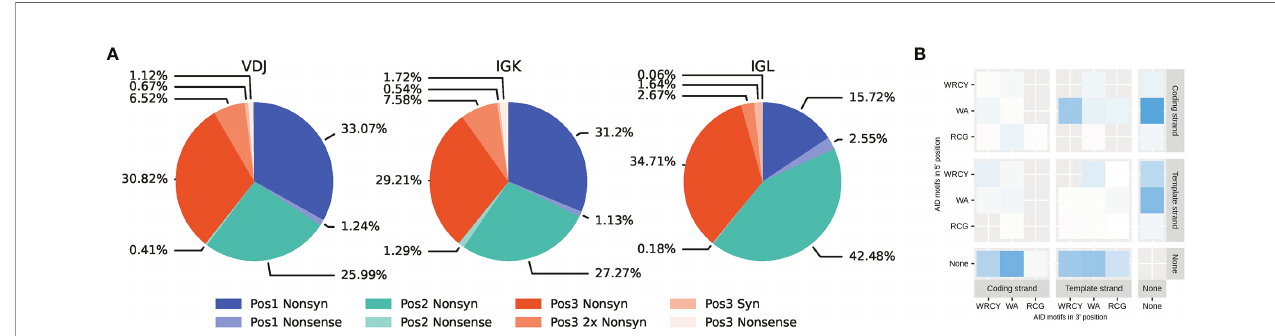
FIGURE 3 | Relative contributions of synonymous, non-synonymous and nonsense tandem dinucleotide substitutions for VDJ, VJ-kappa and VJ-lambda. (A) Results are split per position in the codon. Position 1 represents 5 ’ and middle base on the coding strand, position 2 represents middle and 3 ’ base and position 3 represents the 3 ’ base of the codon and the 5 ’ base of the downstream codon. Tandem dinucleotide substitutions causing two separate synonymous mutations in position 3 are displayed as a separate category. (B) Analysis of AID motifs present in tandem substitution for IGHV sequences. The 3 motifs associated with AID activity (WRCY, WA, and RCG) were identi fi ed in position 5 ’ or 3 ’ of the tandem. The motifs were considered in forward (coding) and reverse